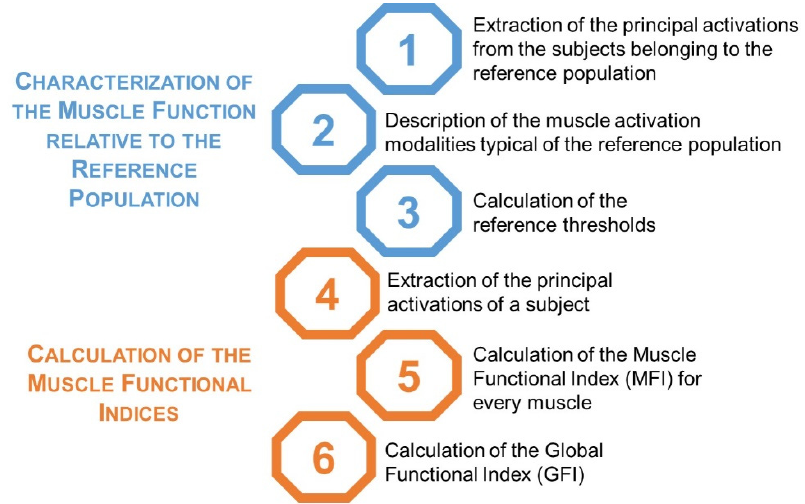
Figure 1. Pipeline for the definition of the muscle functional indices.